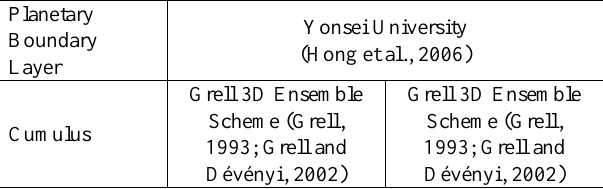
Table 1. Simulation main configurations for both